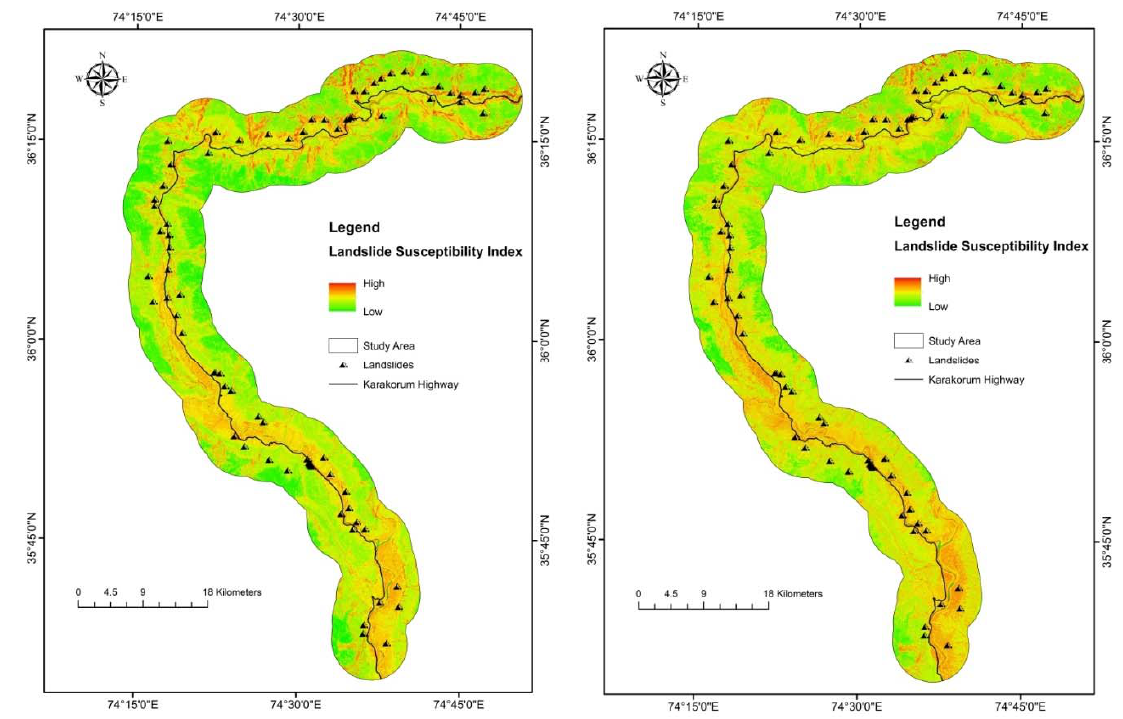
Figure 8. LSI Maps generated by the XGBoost and RF Figure 8 . LSI Maps generated by the XGBoost and RF models.